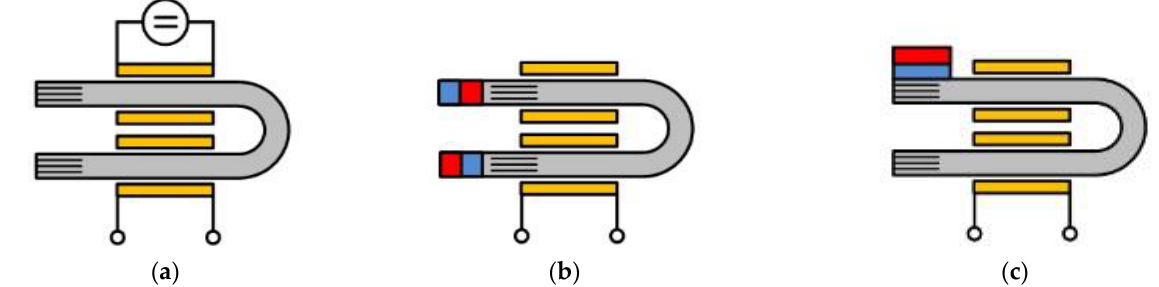
Figure 1. The selected design of active sensors: ( a ) DC supply excitation; ( b ) with permanent magnets positioned on the yoke poles; ( c ) with a permanent magnet positioned in one part of the yoke only.